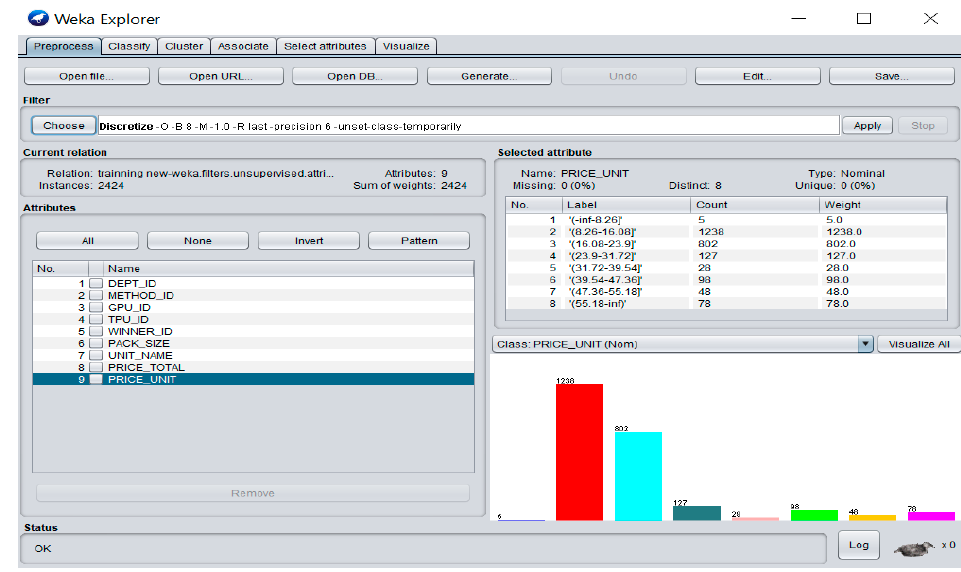
Figure 1. Pre-processing stage and discretization in WEKA with eight class